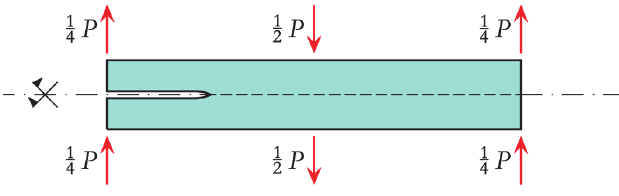
Figure 2: Free-body diagram of the ENF test